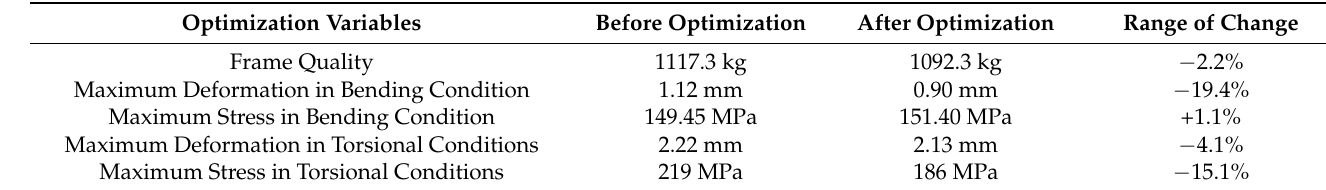
Figure 14. Finite element analysis results of frame optimization structure. ( a ) Frame strain distribution in bending conditions; ( b ) Bending condition frame stress distribution diagram; ( c ) Frame strain distribution for torsional conditions; ( d ) Torsional conditions frame stress distribution diagram. Table 5. Initial values of optimization variables and optimization results.